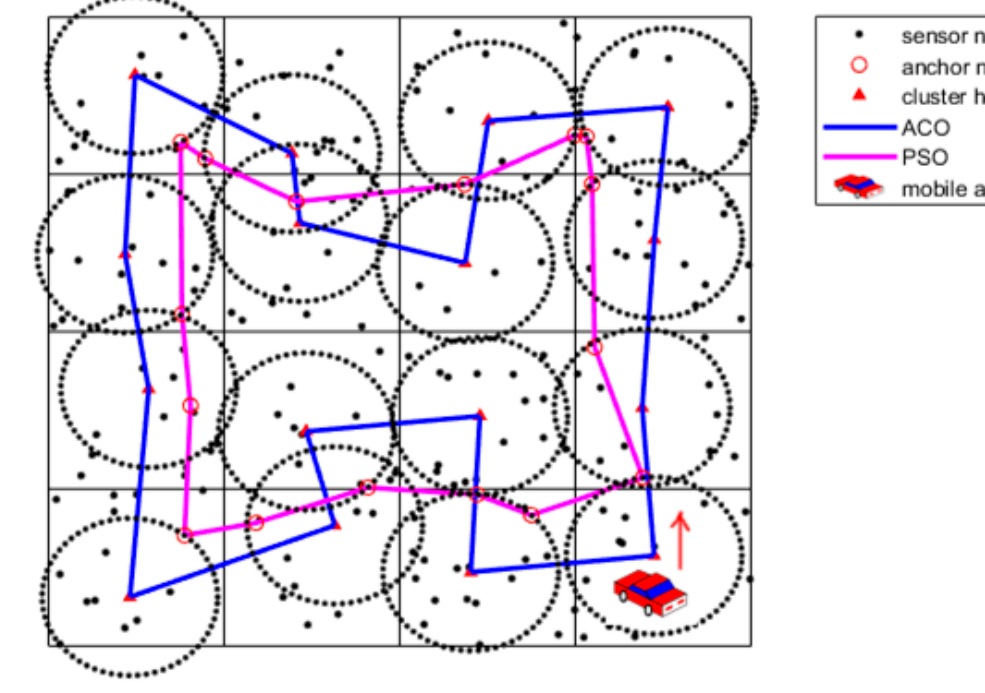
Figure 7. Anchor nodes selection using the PSO algorithm. The pseudocode of the PSO-based anchor nodes selection is described in Algorithm